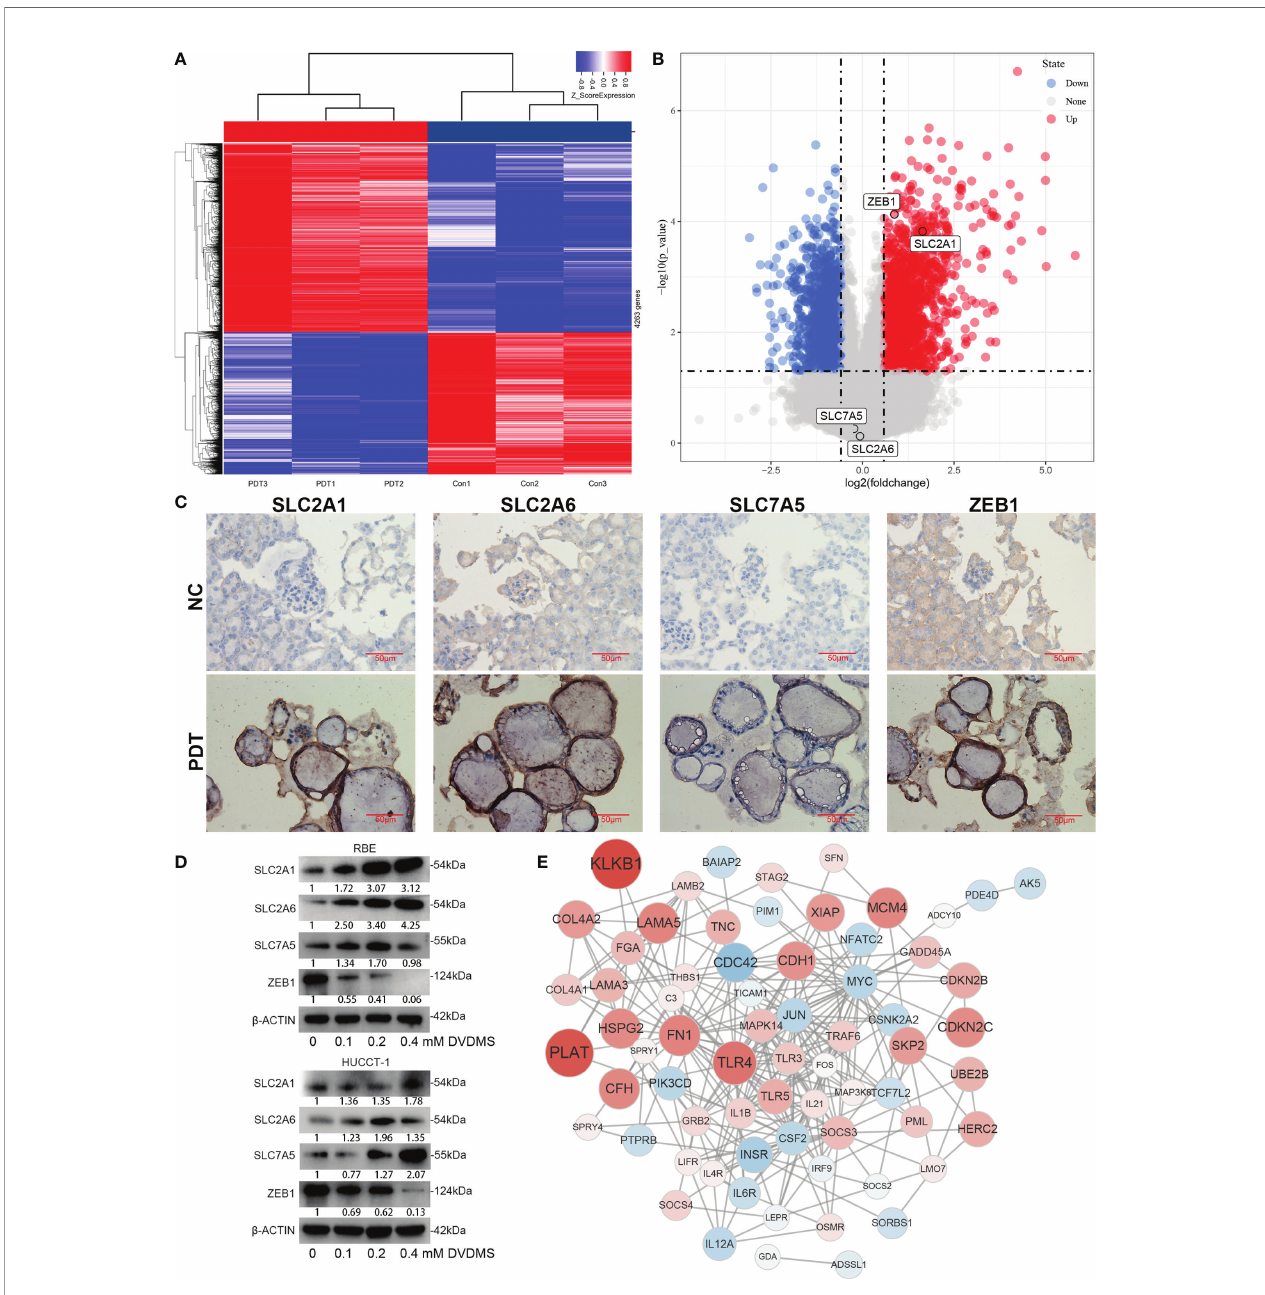
FIGURE 9 | Expression changes and network analysis of Fer-score model genes in PDT. (A, B) The heatmap and volcano plot show the changes of genes after PDT treatment of RBE cells. Among them, red represents upregulation of gene expression, and blue represents downregulation of gene expression. (C) Protein expression changes in organoids of CCA after PDT treatment. (D) Protein expression changes in RBE and HUCCT-1 cells after PDT treatment (bar, 50 m m). (E) Construction of the gene network based on microarray